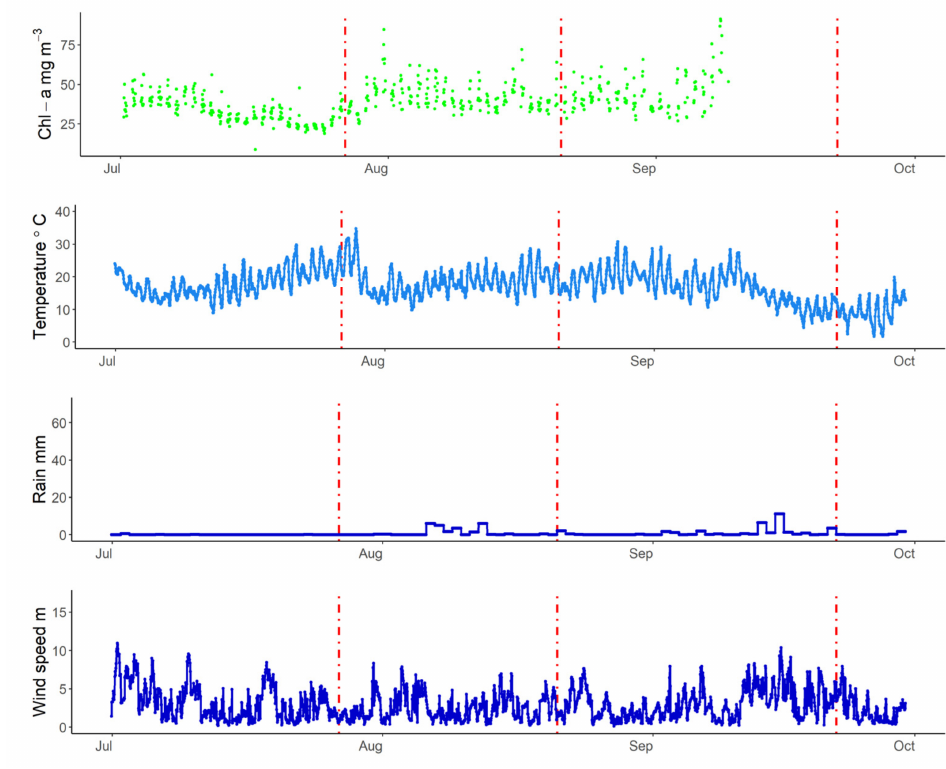
Figure 8. Lake V õ rtsjärv Chl-a (hourly), air temperature (hourly), rain (daily total), and wind speed (hourly) between July and September 2019. Dashed red lines indicate 27 July, 21 August, and 22 September